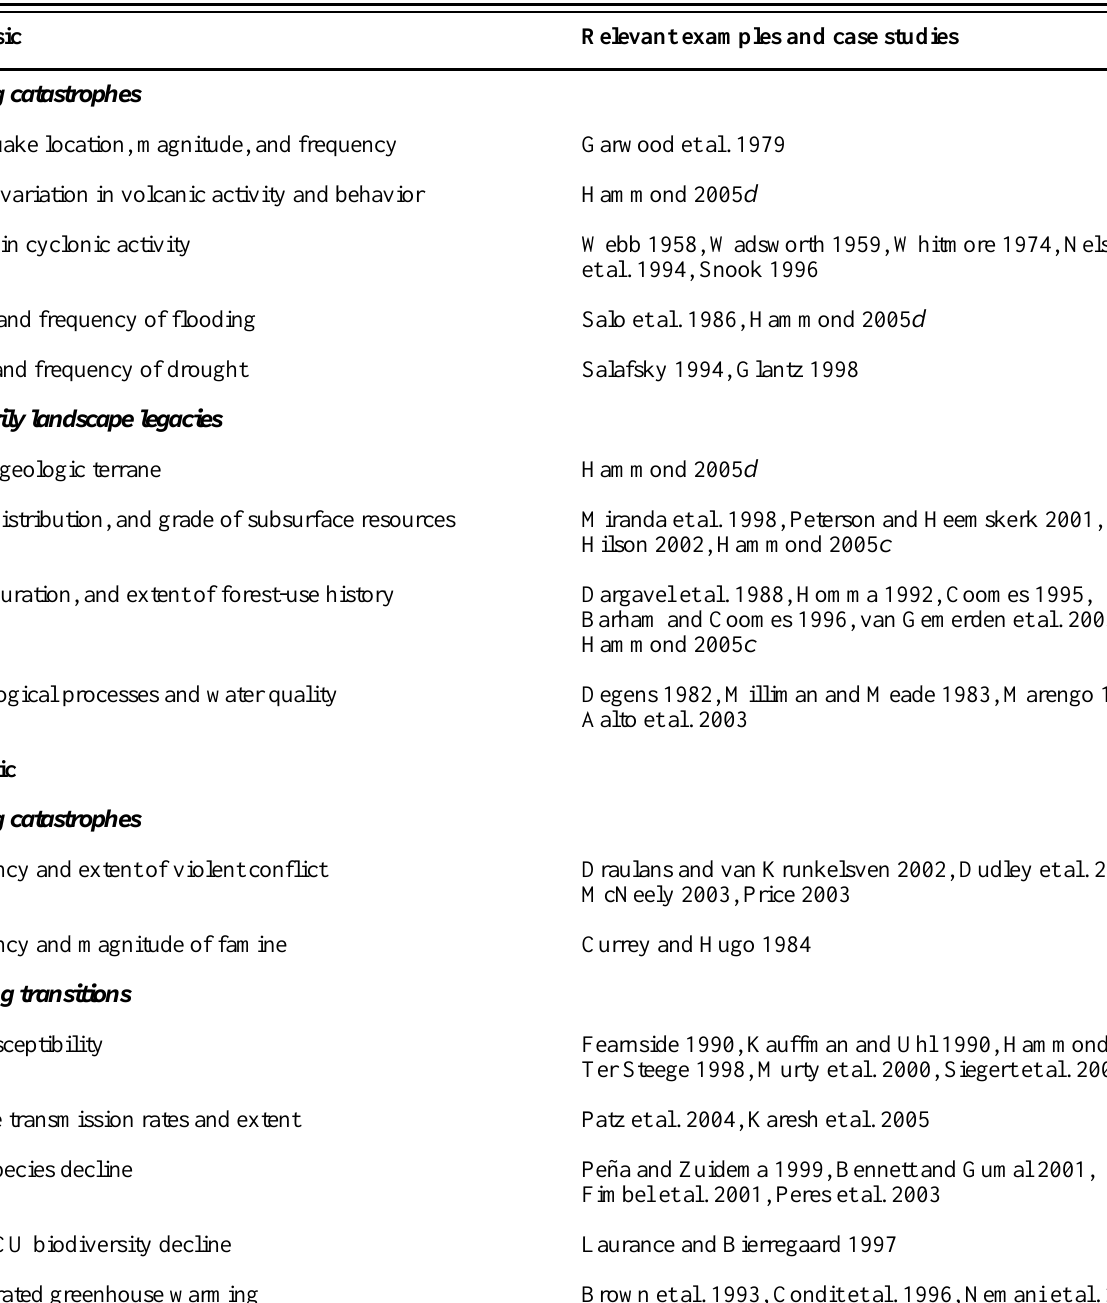
Table 1. Some examples of poorly integrated extrinsic and intrinsic background conditions grouped by their influence on the relationship between management objectives and outcomes. Conditions are not necessarily independent. CCU stands for commercial consumptive use (sensu Freese 1998), RHT for resource and habitat taboos (sensu Colding and Folke 2001), and TEK for traditional ecological